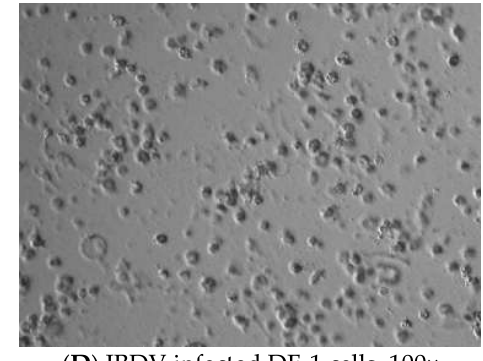
( C ) Uninfected DF-1 cells, 100× ( D ) IBDV infected DF-1 cells, 100× Figure 6. Cytopathic effects (CPE) of feline coronavirus (FCoV) with a lipid envelope and infectious bursa virus (IBDV) without a lipid envelope. ( A ) Felis catus whole fetus-4 (fcwf-4) cells without virus, monolayer at 24 h, 100×; ( B ) Fcwf-4 cells infected with FCoV/NTU156 become multinucleated giant cells (arrows) at 24 h post-inoculation (hpi), 100×; ( C ) DF-1 cells without virus, monolayer at 24 h, 100×. ( D ) DF-1 cells infected with IBDV have granulation around nuclei, cell rounding, and detachment at 72 h, 100×.